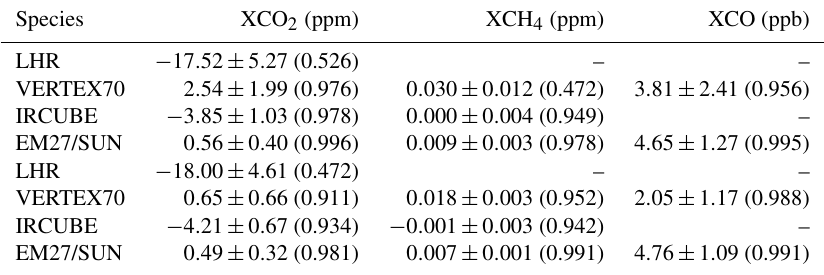
Table D1. Statistics of the intercomparison results for LHR, Vertex70, IRcube, and EM27/SUN vs. HR125LR for measurements performed in 2017 with SZA < 75 ◦ . The values provided are the mean bias ± the standard deviation and the correlation coefficient ( r ). The statistics in the first four rows cover the full year of measurements in 2017, while those in the last four rows are for the measurements performed